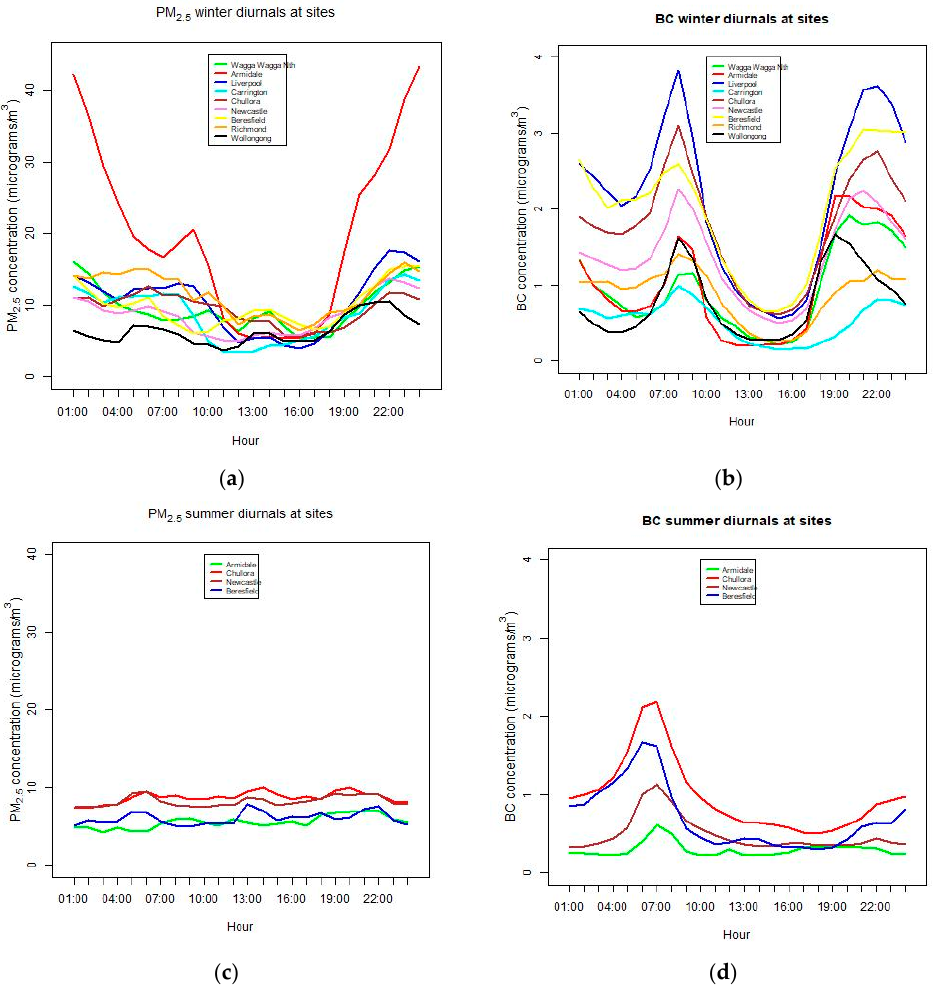
Figure 3. PM 2.5 and BC diurnal profiles: ( a , b ) for winter period at Wagga Wagga North, Armidale, Liverpool, Carrington, Chullora, Newcastle, Beresfield, Richmond and Wollongong; and ( c , d ) for summer period at Armidale, Chullora, Newcastle and Beresfield. Diurnal profiles are derived from averaging of hourly data over a number of years at each hour of the 24-h period. As expected, there is stronger correlation between BC and PM 2.5 during the winter (R 2 of 0.15–0.65)